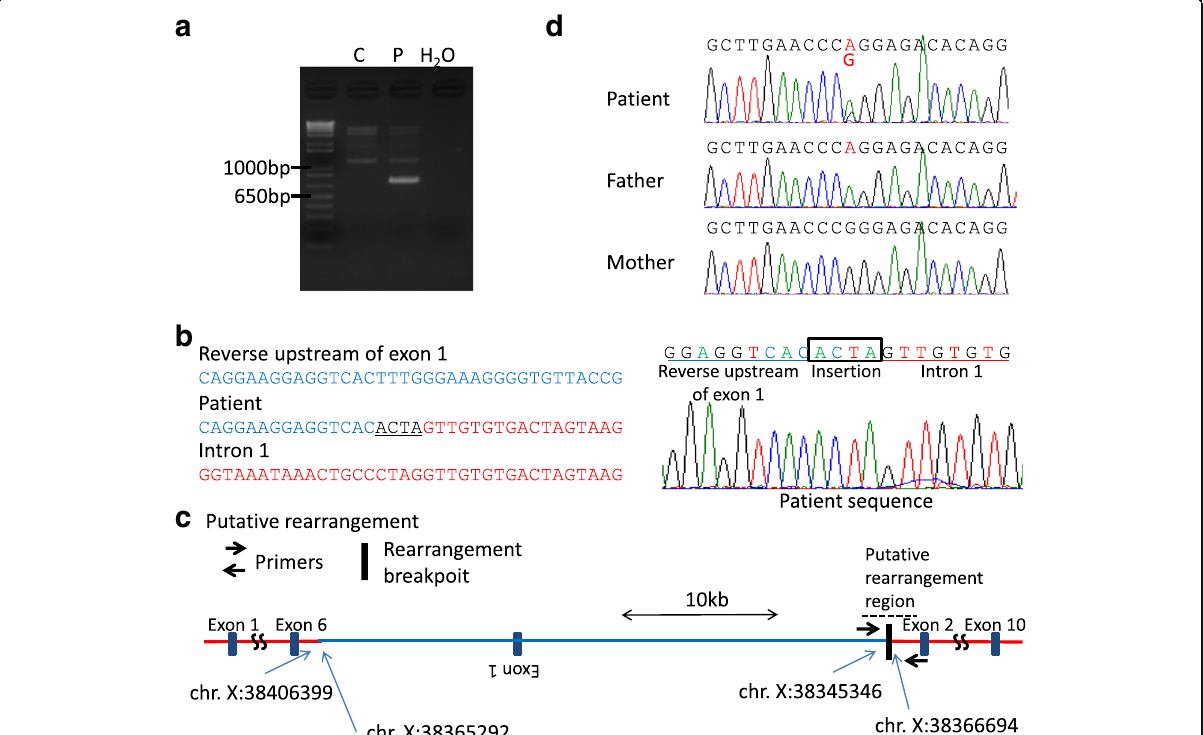
Fig. 3 The complex rearrangement in the OTC gene of the study patient likely occurred via a replication-based mechanism. a Identification of the other junction by PCR. The PCR primer pair successfully amplified the junction product only from the OTCD study patient DNA. P, patient; C, control; H, H 2 O. b Sanger sequencing results for the PCR products including the junction. The normal sequence of the OTC gene upstream region and intron 1 are aligned in blue and red typeface, respectively. Underlined bases denote a non-templated microinsertion at the junction. c Predicted structure of the complex rearrangement leading to the OTC gene duplication. The positions of the PCR primers are indicated by black arrows. The first junction is indicated by a blue arrow. The nucleotide position of the breakpoints on the X-chromosome are also indicated. The position of the two breakpoints in intron 1 were found to be chr. X: 38365292 and chr. X: 38366694, which were 1402bp apart. d Trio-genotyping of the common single nucleotide variant (rs752750694, NM 000531.5:c.-844C>T). The patient ’ s father carries A and her mother carries G/G. The patient was found to be an A/G heterozygote, but her A peak was two-fold higher than the G-peak. The areas under the curve (AUC) were 900 (A) and 328 (G) (Image